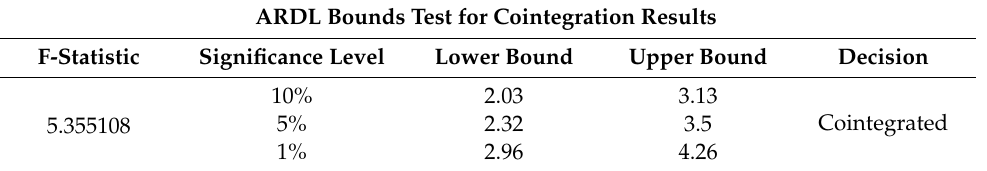
Table 3. Autoregressive Distributed Lag (ARDL) Bounds Test for Cointegration